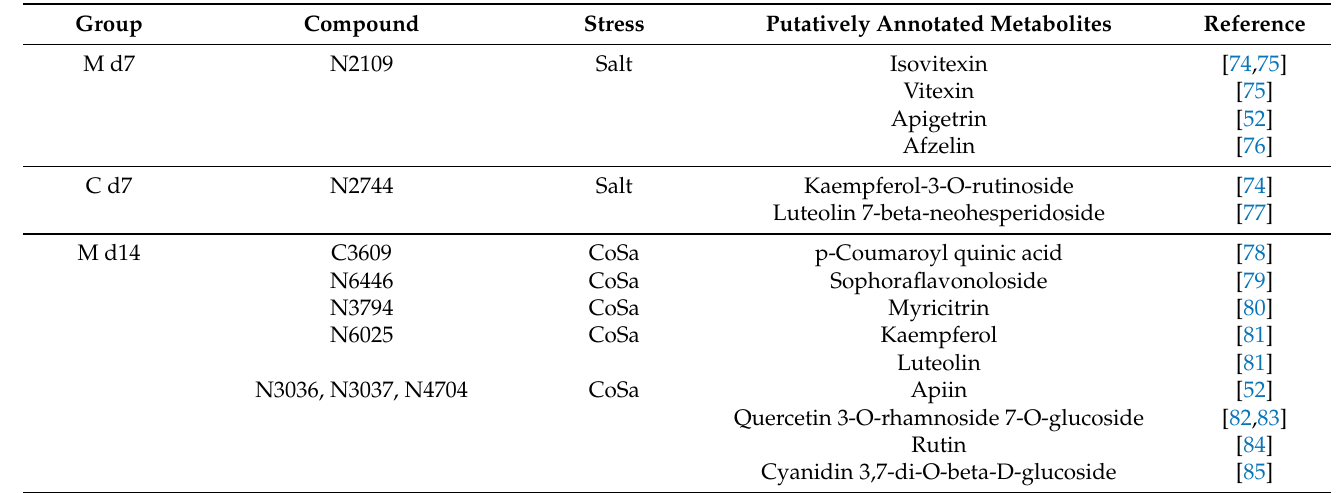
Table 4. Putatively annotated metabolites from the network analysis of all six investigated groups. All annotated metabolites were enriched due to stress treatment and detected in positive (starting with C) or negative mode (starting with N). Harvest time points are indicated as d1, d7 and